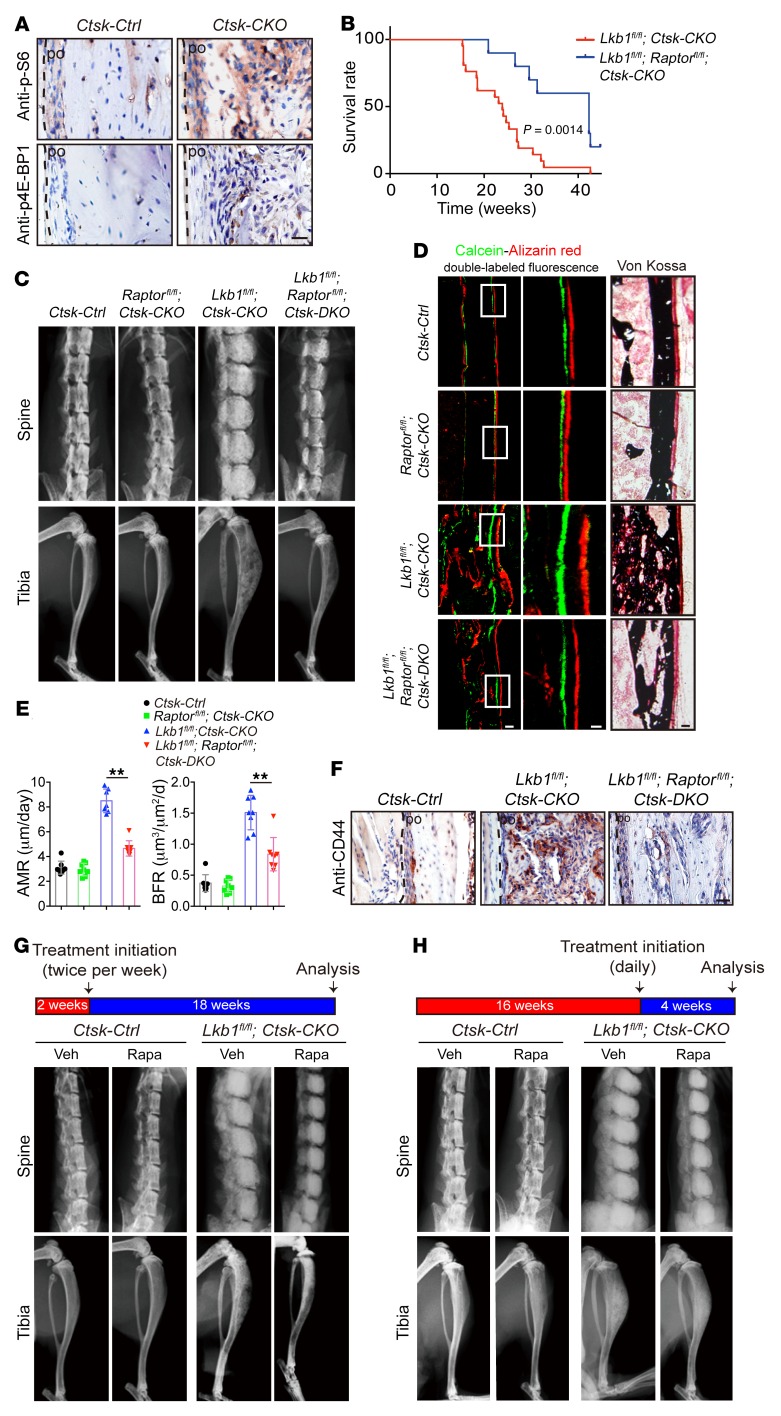
Inhibition of mTOR signaling delays tumor progression of Ctsk-CKO mice.(A) Immunostaining of phosphorylated mTORC1 catalytic substrates ribosomal protein S6 (p-S6) and p–4E-BP1 in sections of 20-week-old Ctsk-Ctrl and Ctsk-CKO tibiae. Scale bar: 20 μm. (B) Survival plots showing an extended median life span of 42.3 weeks for Lkb1fl/fl; Raptorfl/fl; Ctsk-DKO mice (n = 10) compared with 23.9 weeks for Lkb1fl/fl; Ctsk-CKO mice (n = 21). P = 0.0014. (C) X-ray images of spines and tibiae from Ctsk-Ctrl, Raptorfl/fl; Ctsk-CKO, Lkb1fl/fl; Ctsk-CKO, and Lkb1fl/fl; Raptorfl/fl; Ctsk-DKO mice. (D and E) von Kossa staining and the periosteal MAR and BFR via calcein–alizarin red double labeling of tibiae from 5-week-old Ctsk-Ctrl, Raptorfl/fl; Ctsk-CKO, Lkb1fl/fl; Ctsk-CKO and Lkb1fl/fl; Raptorfl/fl; Ctsk-DKO mice. Scale bars: 50 μm (left); 20 μm (middle); 50 μm (right). (F) Immunostaining of CD44 expression in sections of 20-week-old Ctsk-Ctrl, Lkb1fl/fl; Ctsk-CKO, and Lkb1fl/fl; Raptorfl/fl; Ctsk-DKO tibiae. Scale bar: 100 μm. (G and H) Representative x-ray images of spines and tibiae showing that treatment of Ctsk-Ctrl and Ctsk-CKO mice with rapamycin twice per week from 2 weeks old to 20 weeks old (G) or daily from 16 weeks old to 20 weeks old (H) delayed the tumor growth of Ctsk-CKO mice. Similar results were obtained from analyses of both male and female mice for each genotype. Data are represented as mean ± SEM. **P < 0.01, unpaired Student’s t test (B) and 2-way ANOVA (E).